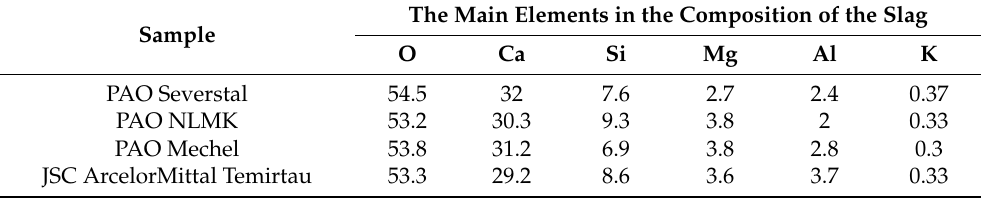
Table 4. Fractional composition of granulated blast furnace slags from the calibration set.